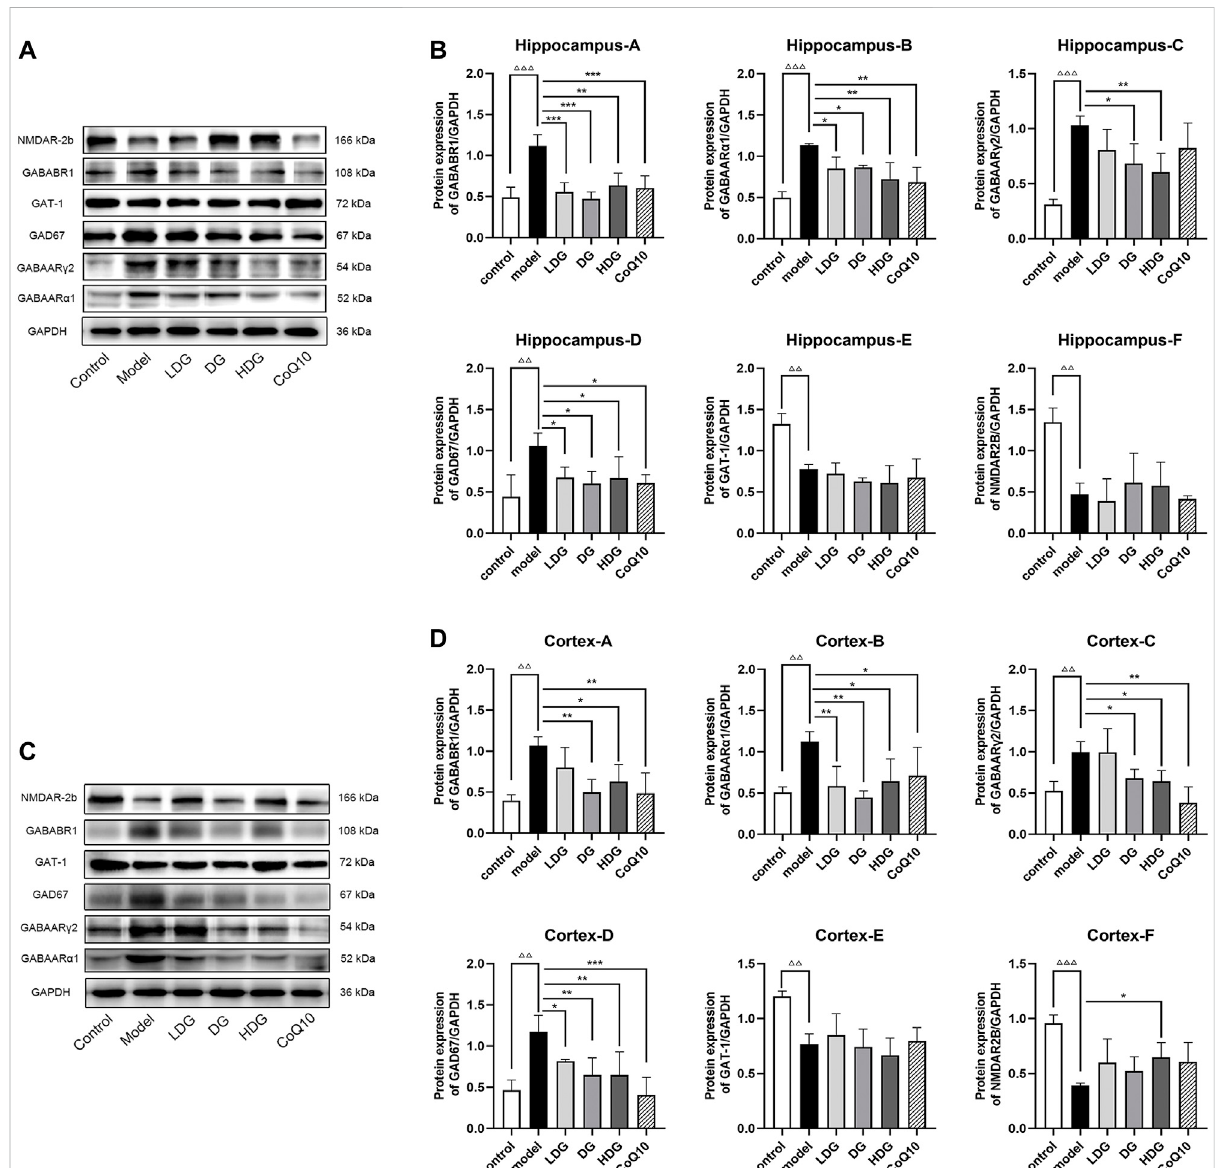
FIGURE 6 Regulation of GABA/Glu pathway-related protein expression levels in all groups. The representative images in hippocampus (A) and prefrontal cortex (C) and the protein levels of GABAAR α 1, GABAAR γ 2, GABABR1, GAD67, GAT-1 and NR2B in hippocampus (B) and prefrontal cortex (D) are shown. Datawereexpressed as(mean±SD), ΔΔ p < 0.01, ΔΔΔ p < 0.001vs.control group;* p < 0.05,** p < 0.01,*** p <